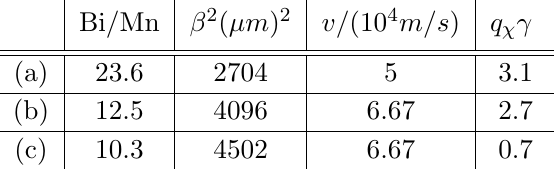
Table 2 . Used parameters in (cid:12)gure